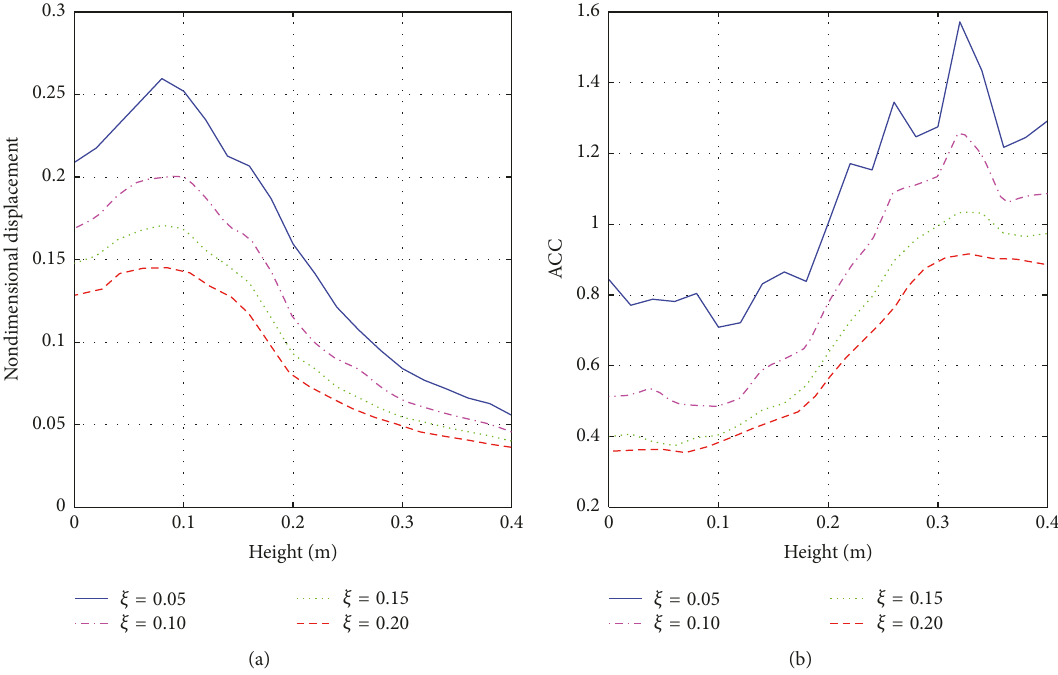
Figure 9: Comparison of nondimensional displacement for a seismic isolated structure with QZS ( 𝑇 = 1